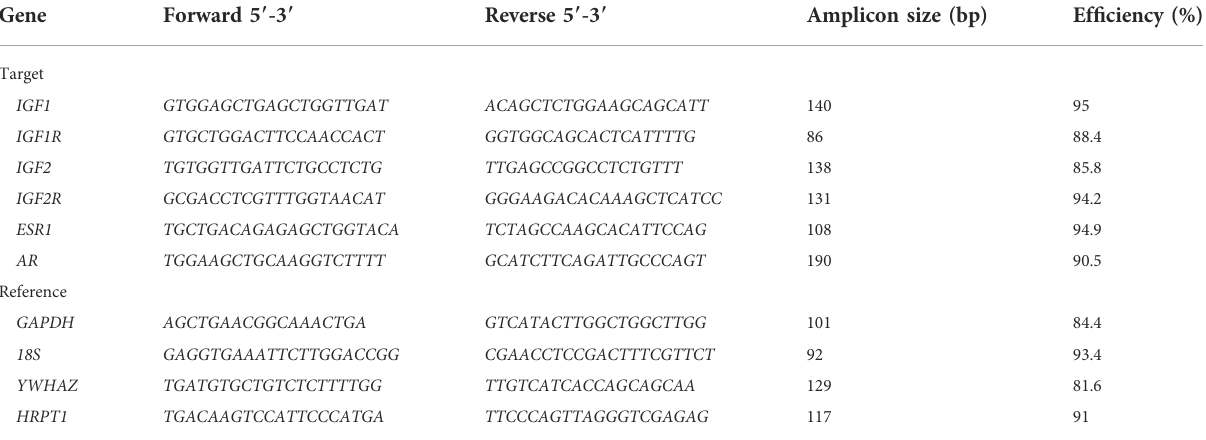
TABLE 1 Primer pairs of target and reference